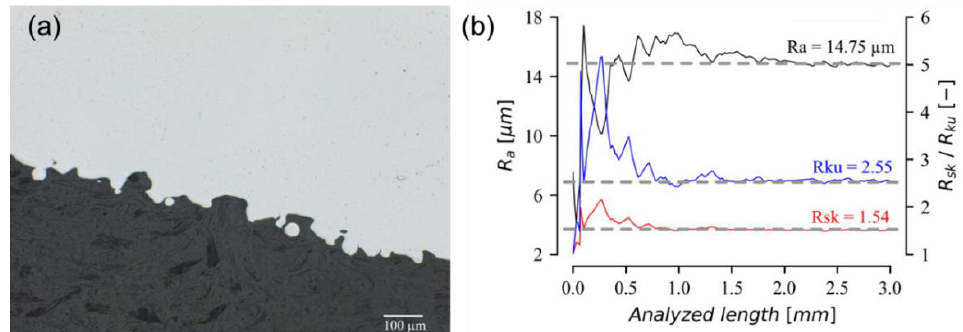
Figure 3. Surface roughness analysis ( a ) cross-sectional optical image of the surface in build direction ( b ) surface roughness values vs analyzed length.